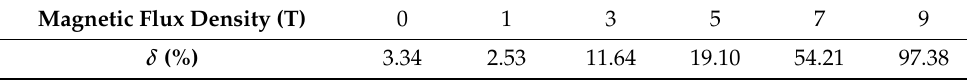
Table 1. The alignment degree of CFs ( δ ) in CF–rubber composites.